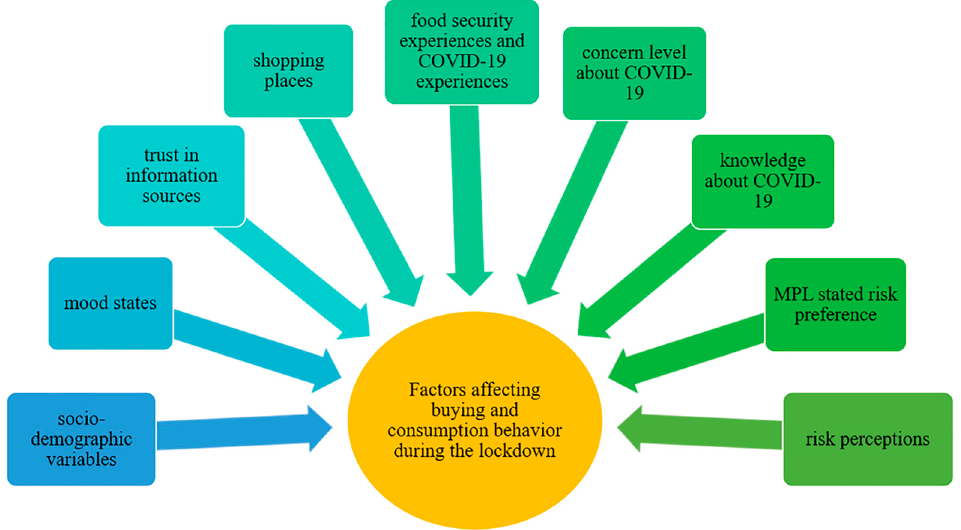
Figure 1. The framework of factors affecting consumers’ food buying and consumption behavior during the lockdown.